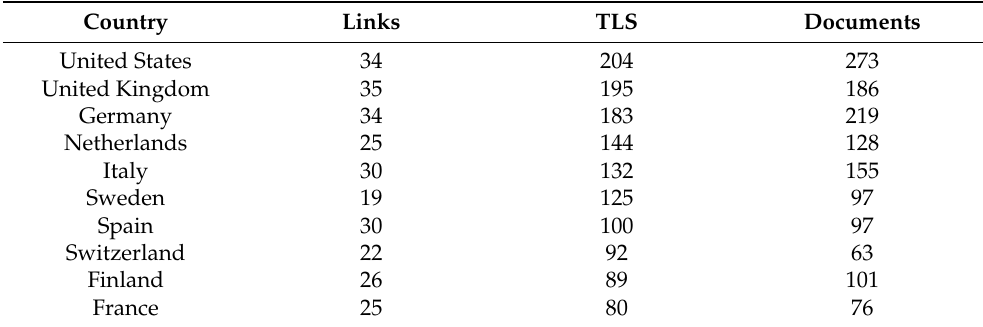
Table A3. Structural bibliometric indicators for the top 10 countries included in the co-authorship network (ranked by TLS).